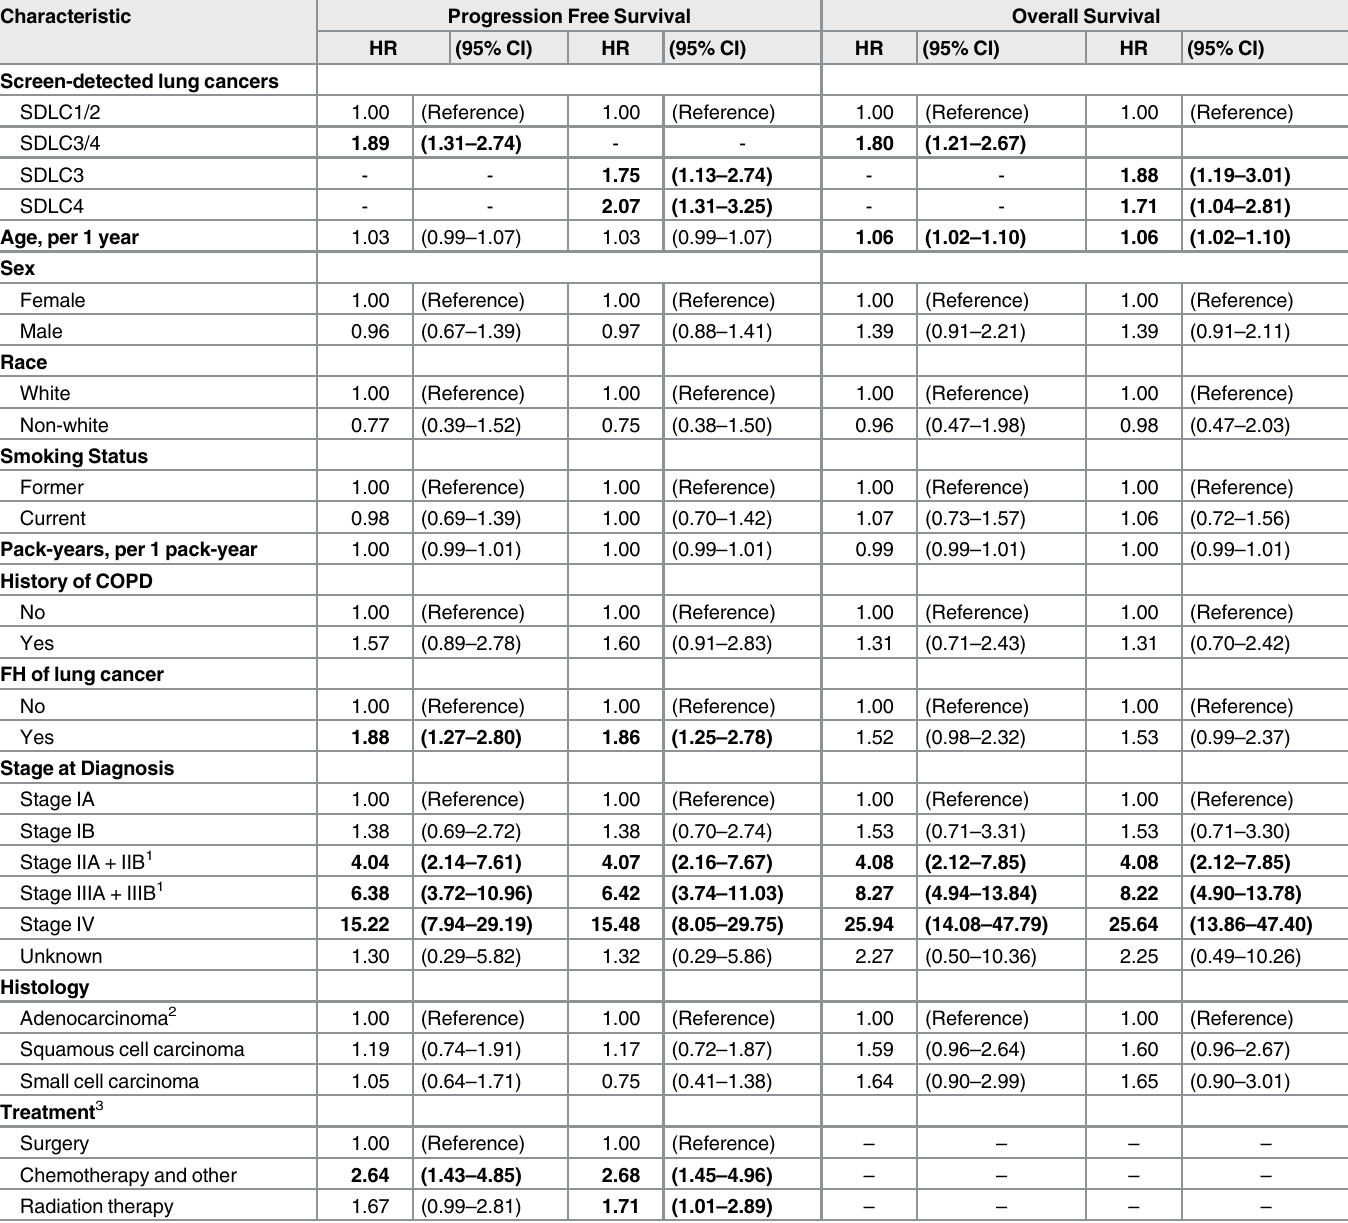
Table 4. Multivariable Cox Proportional Hazards Models for Progression Free and Overall Survival for the Screen-Detected Cohorts.